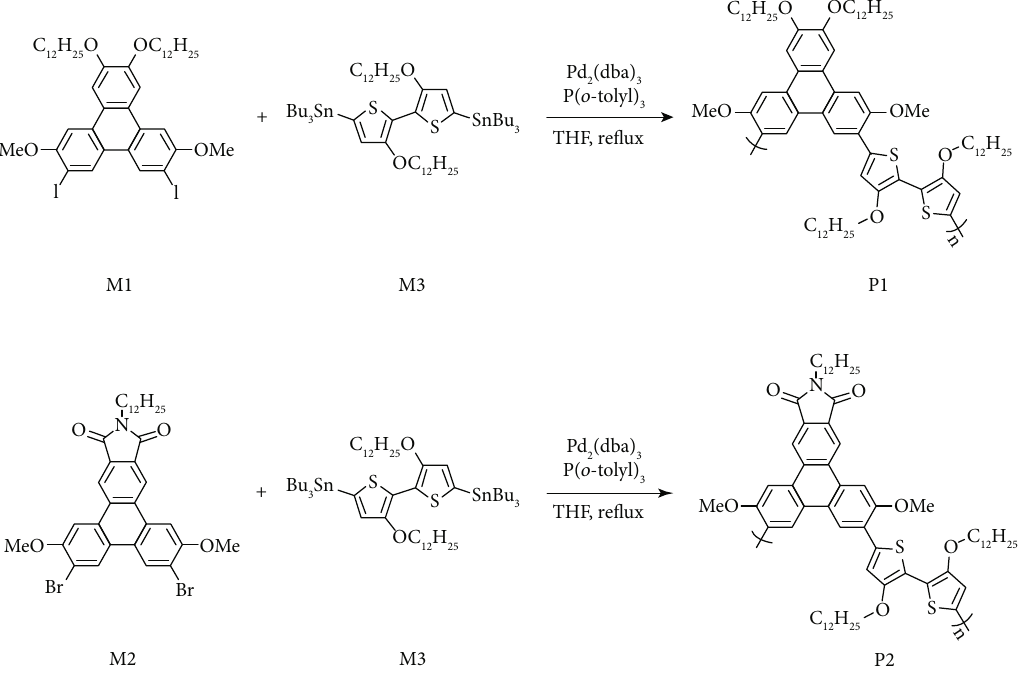
Scheme 2: Synthesis of polymers P1 and P2